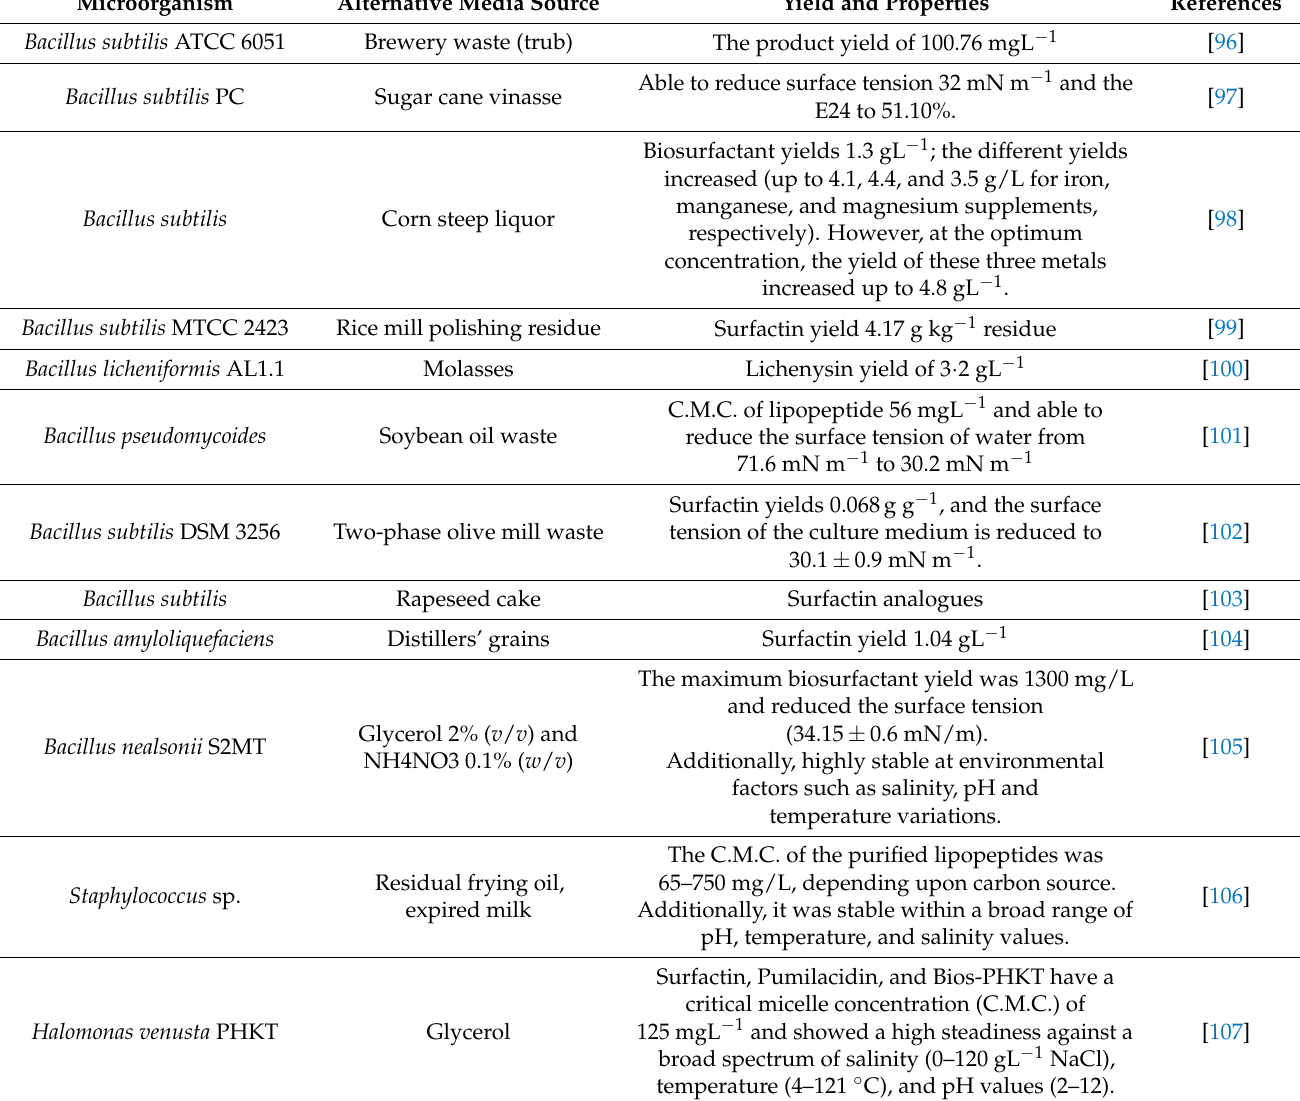
Table 4. The common alternative substrates and their impact on biosurfactant